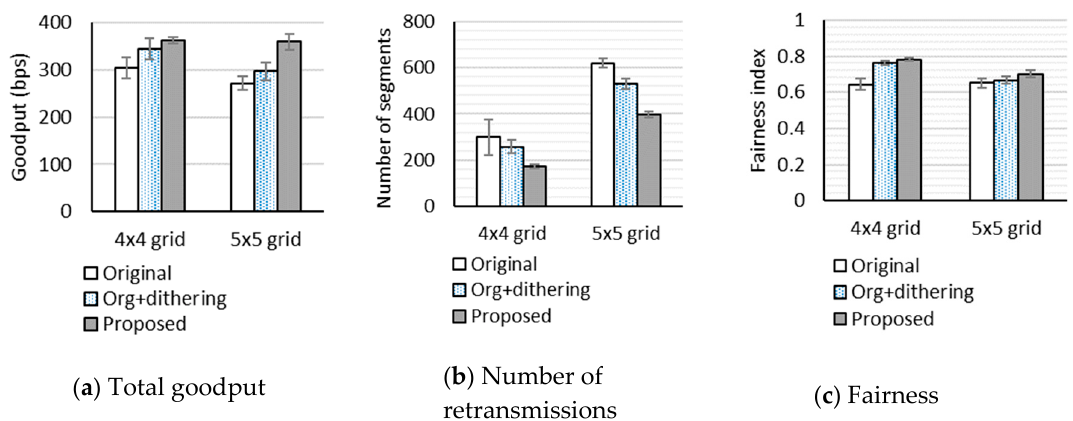
Figure 5. Performance in 4 × 4 grid and 5 × 5 grid topology networks when ContikiMAC is used.